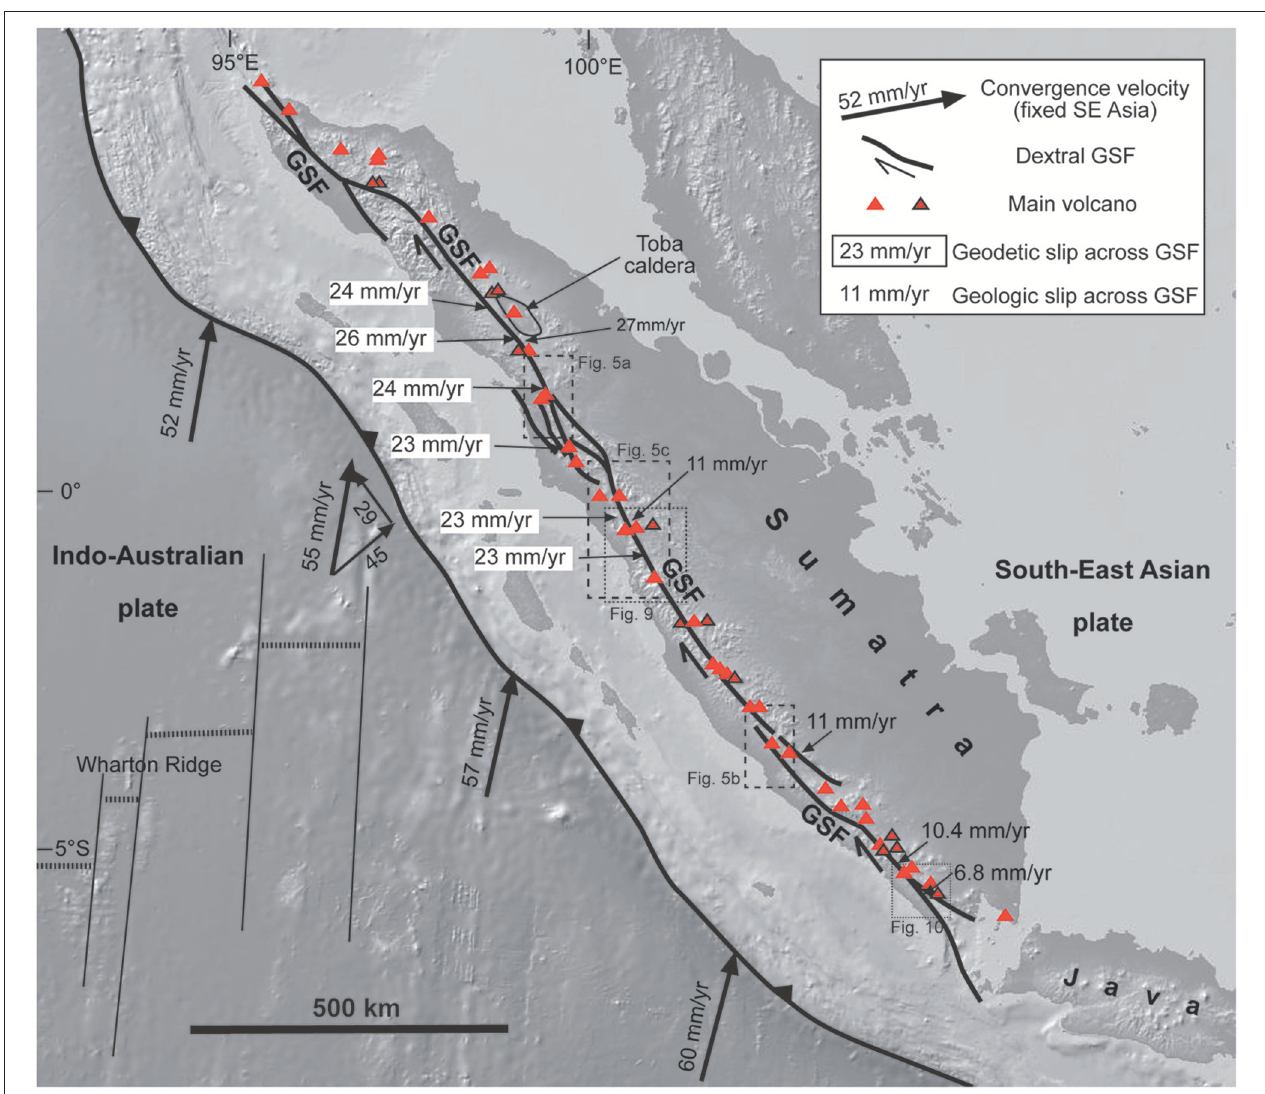
FIGURE 1 | Overview of Sumatra Island, showing the location of the active volcanoes (red triangles from the Smithsonian Global Volcanism Program, red triangles with black frame from Sieh and Natawidjaja, 2000) considered in this study and the